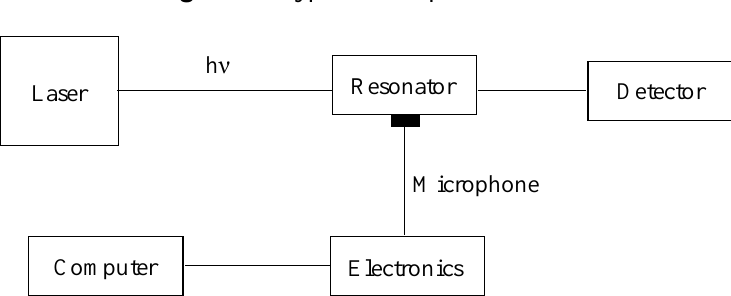
Figure 1. Typical PA spectrometer.